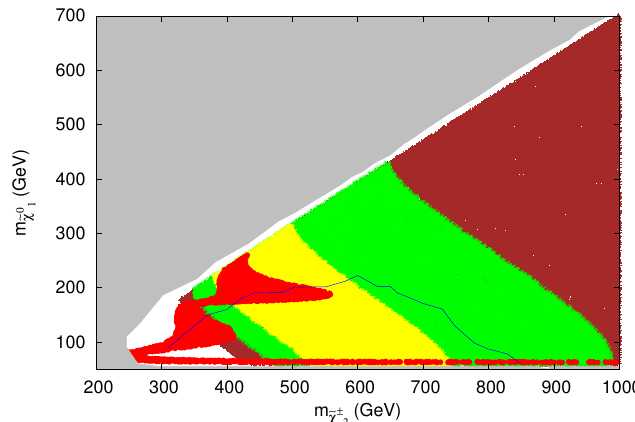
Figure 3 . Exclusion contour in the m Heavy Slepton (MCLHHS ( f W )) model. The blue line represents the exclusion obtained by us using the ATLAS 3 l + E= T search data from Run II. Colors and conventions are same as in (cid:12)gure